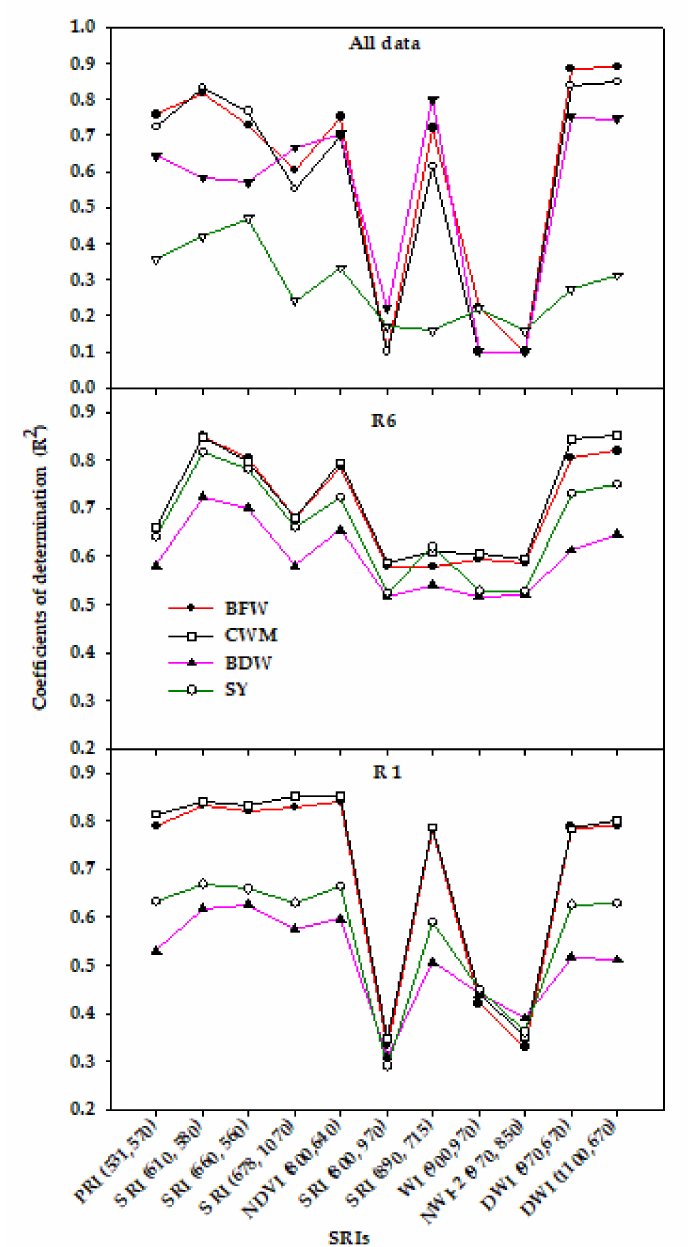
Figure 3. Coe ffi cients of determination (R 2 ) for the relationship between di ff erent spectral reflectance indices (SRIs) and vegetative growth traits (biomass fresh weight (BFW), biomass dry weight (BDW), canopy water mass (CWM), and seed yield (SY)) at each growth stage across three irrigation regimes ( n = 24)andforpooleddataofreplications, growthstages, irrigationregimes, andseasons( n = 48):R1and R6 indicate the beginning bloom and full seed growth stages,